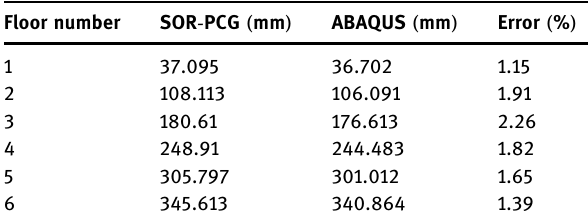
Table 2: Horizontal displacement of each layer of the frame Floor number